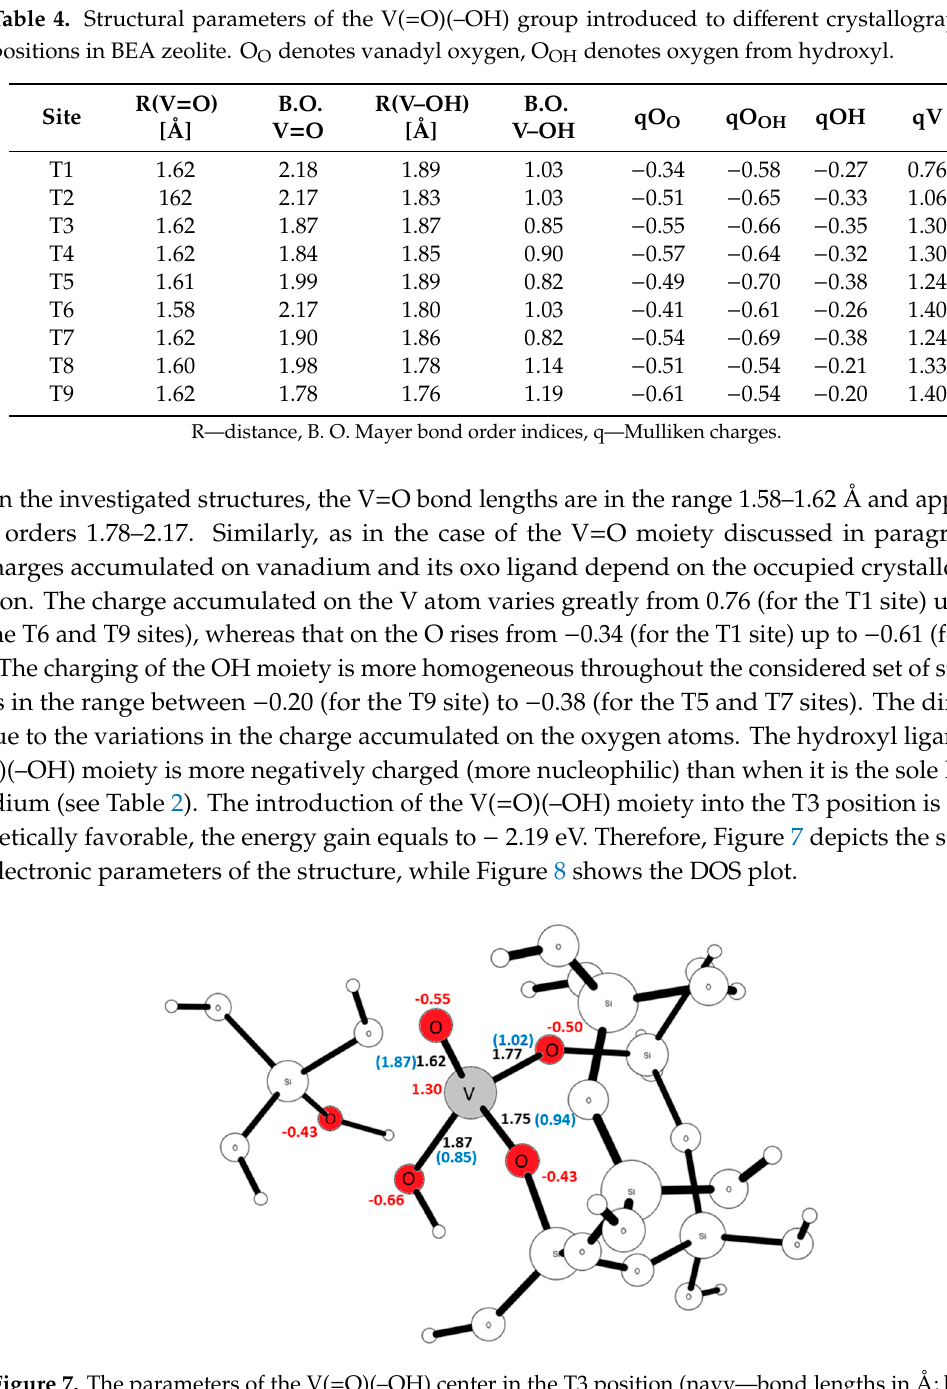
Figure 7. The parameters of the V(=O)(–OH) center in the T3 position (navy—bond lengths in Å; blue, in parentheses—bond order indices; red—Mulliken charges).